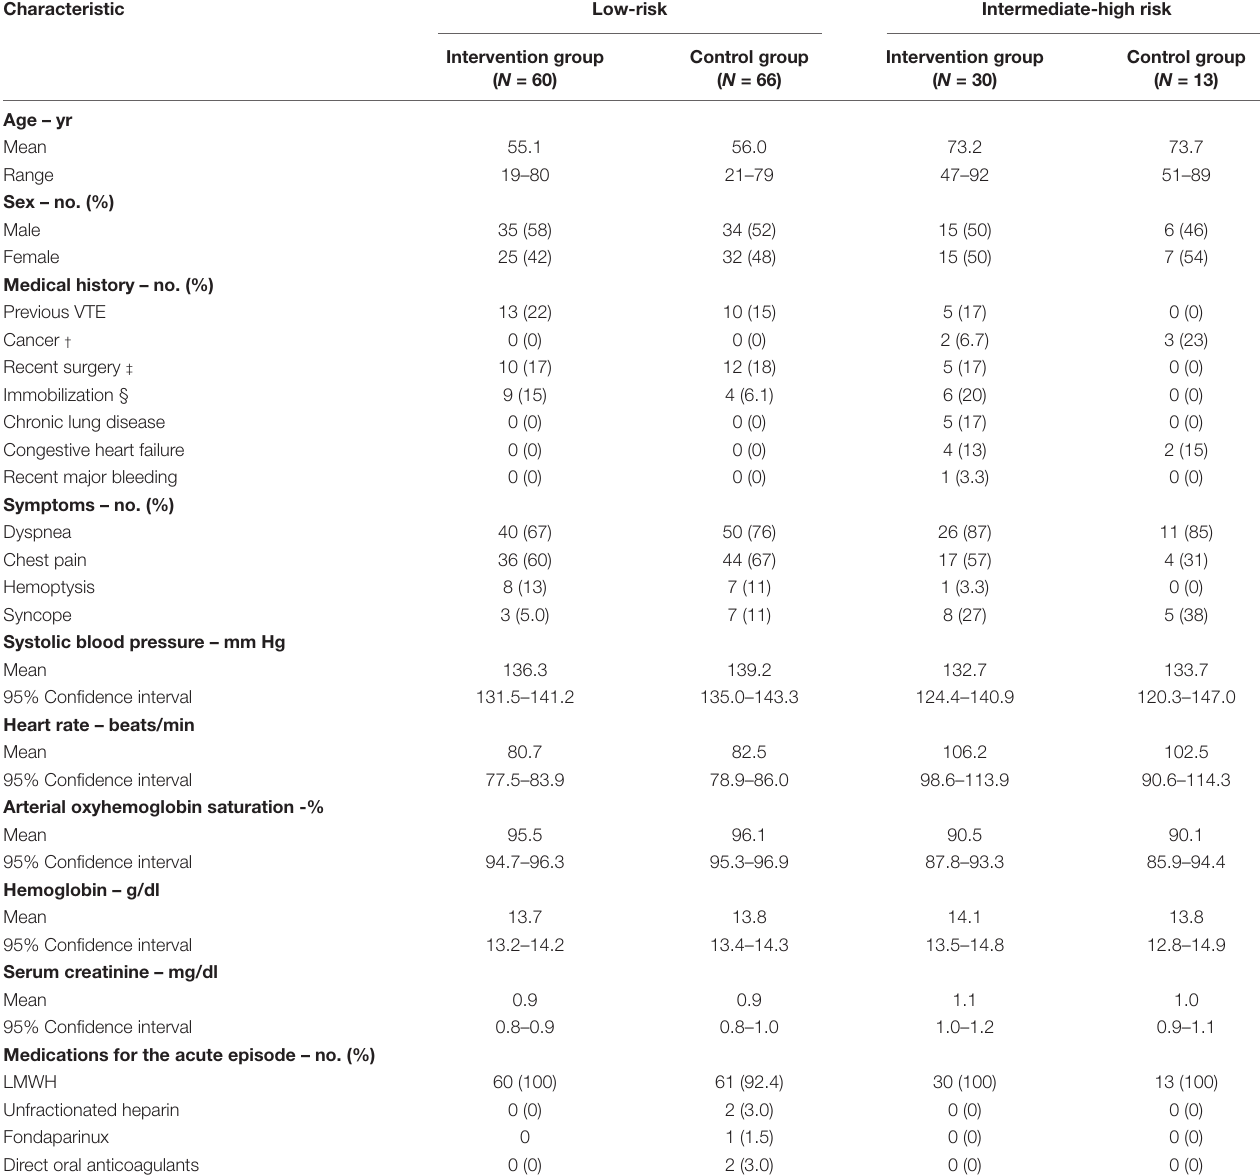
TABLE 1 | Baseline characteristics of the